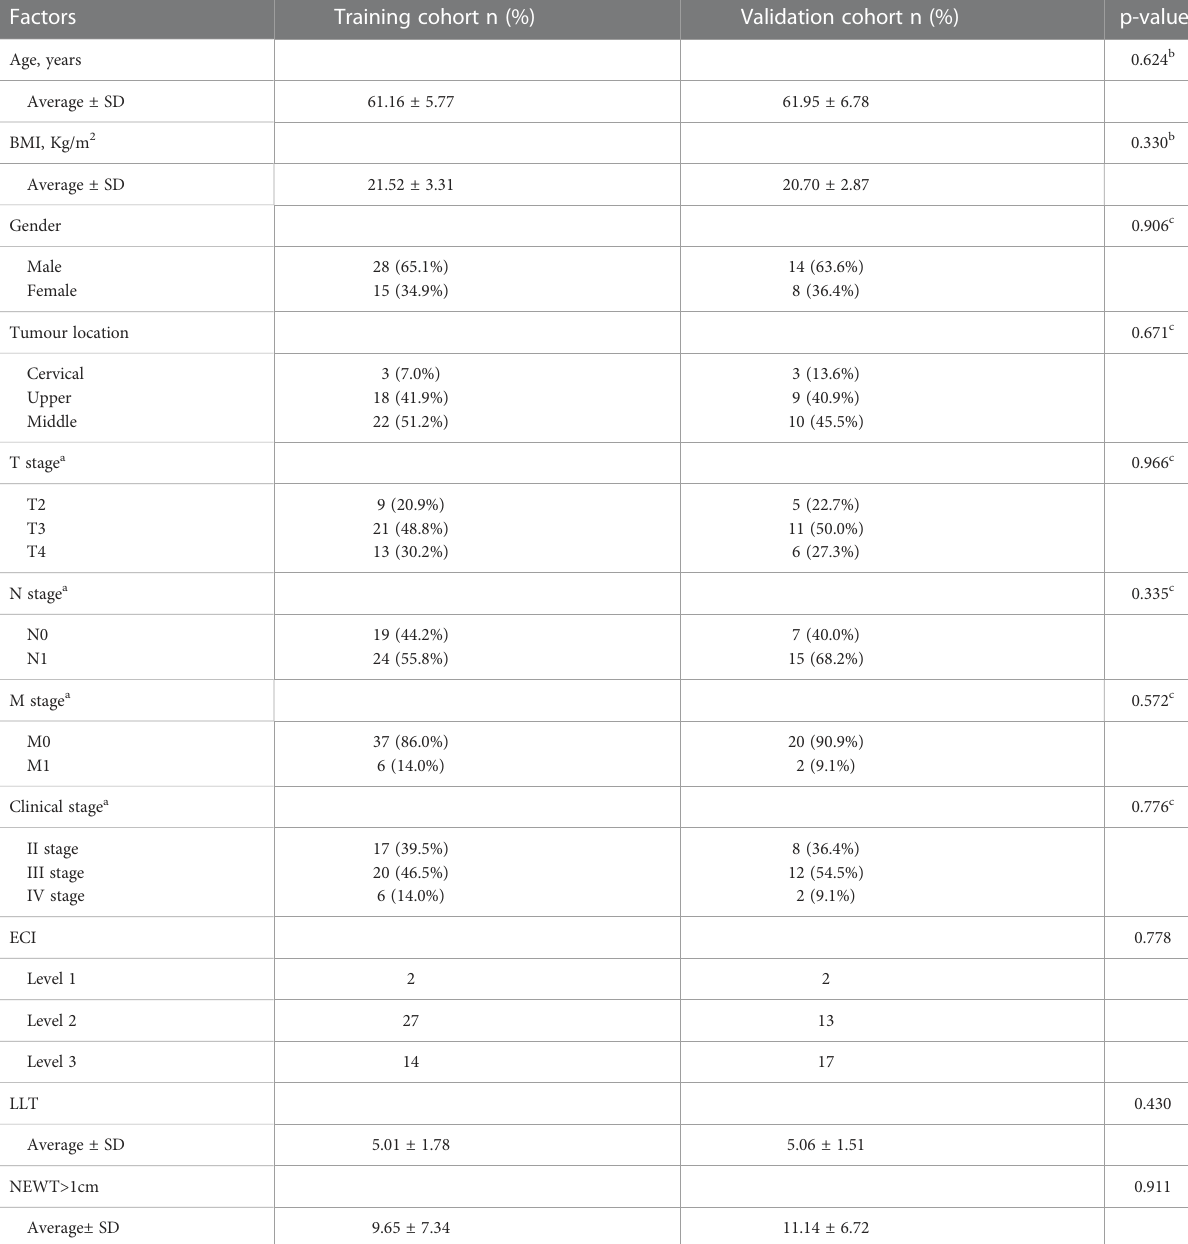
TABLE 1 Clinical characteristics of 65 patients with ESCC after de fi nitive